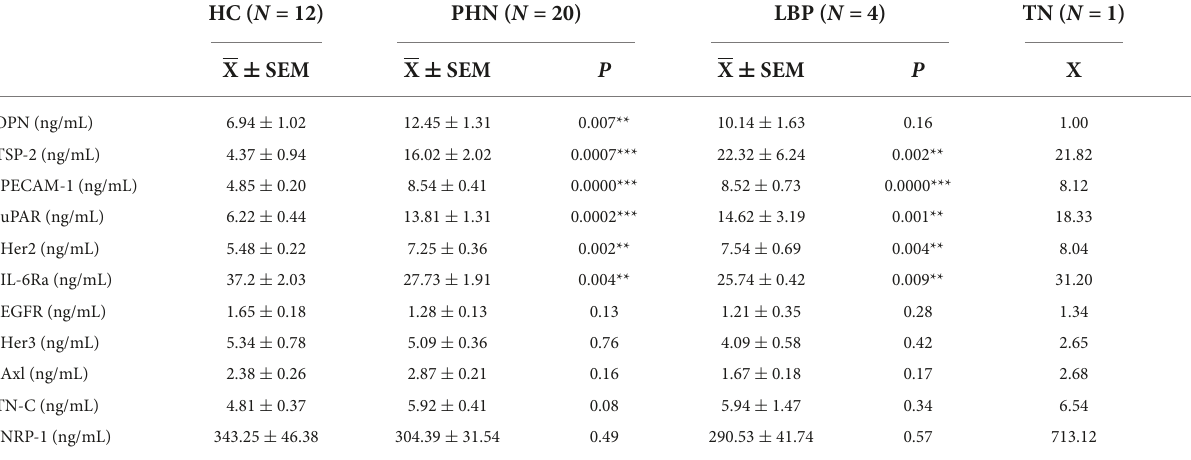
TABLE 3 Serum levels of angiogenic factors in healthy controls and patients with PHN, LBP, or